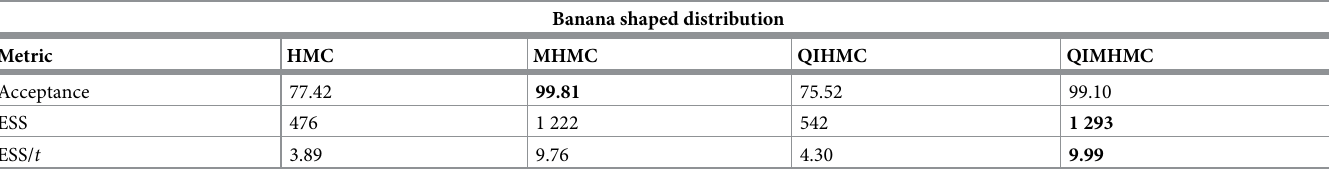
Table 2. Banana shaped distribution results averaged over 10 runs. The time t is in seconds. The values in bold indicate that the particular method outperforms the other methods on that specific metric. Banana shaped distribution